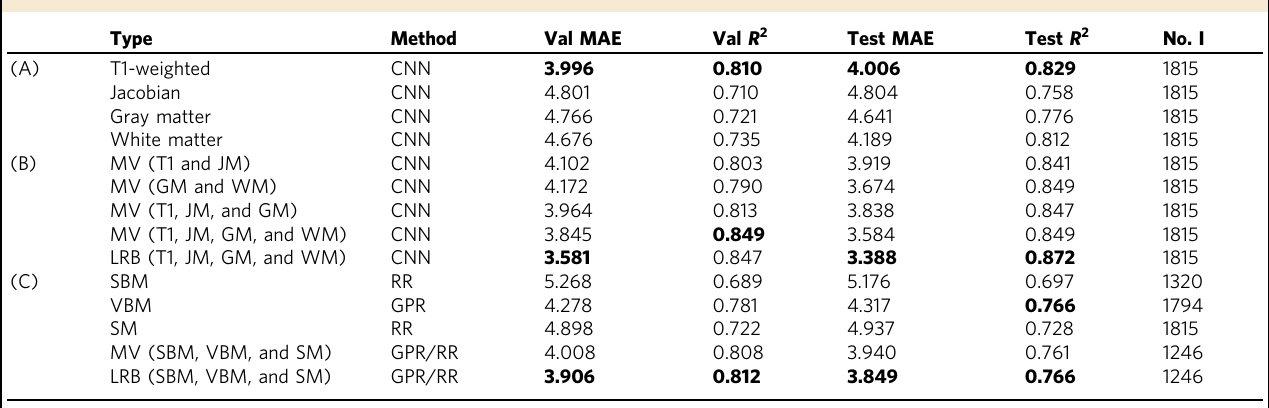
(A) The best results are shown in bold. (B) The training/validation/test split is the same as for (A).